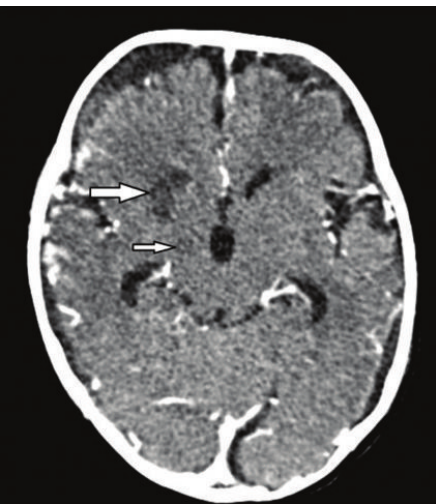
Figure 3: Nonenhanced brain computed tomography scan eight weeks after admission. Axial image shows significant nonob- structive hydrocephalus resulting in compression of cerebral parenchyma. There are hypodensities involving the periventricular regions and the frontal lobes bilaterally with associated cystic encephalomalacia, more on the